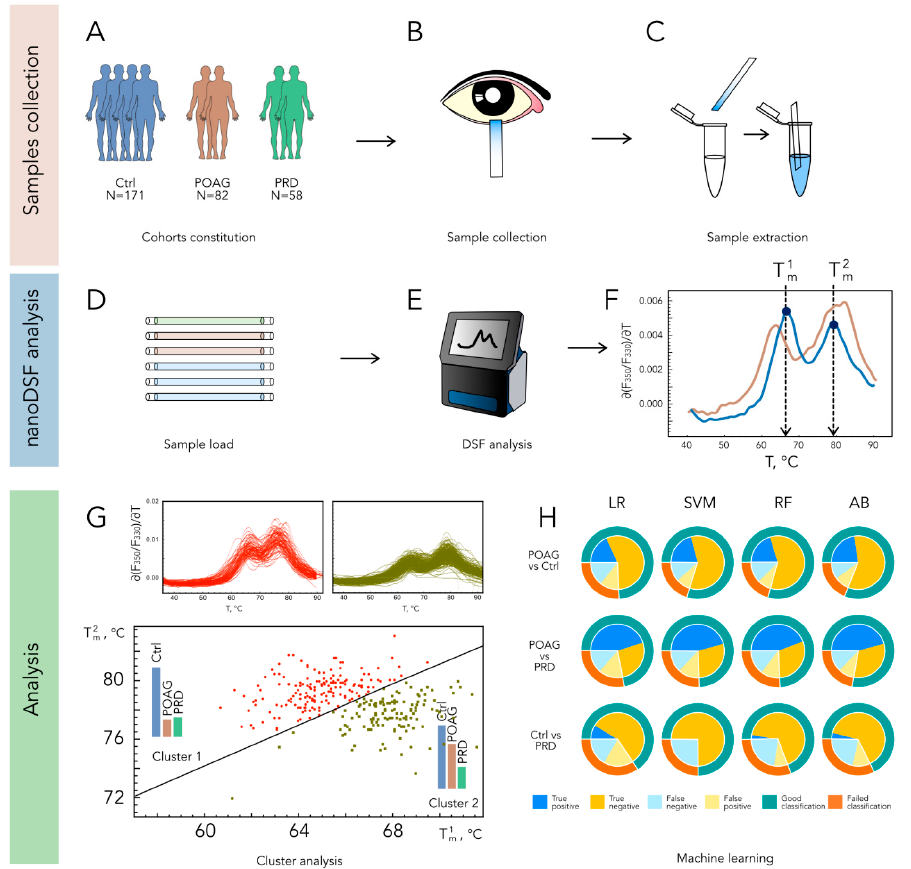
Figure 1. A workflow designed for the identification of POAG patients based on TFDP. Tear samples are collected using Schirmer tear strips in a cohort of individuals with refraction abnormalities (Ctrl), POAG, or PRD ( A – C ) and analyzed by nanoDSF yielding typical profiles with two peaks exhibiting characteristic shifts in POAG (( D – F ); normal and POAG-type TFDPs are indicated in blue and brown, respectively). The classification of patients is accomplished using k-means two-parameter clustering of the profiles according to peaks maxima (( G ); TFDPs belonging to clusters 1 and 2 are indicated in red and willow green, respectively), or AI analysis ( H ), where nanoDSF outputs are tested as input data for machine learning algorithms Logistic Regression (LR), Support Vector Machine (SVM), Random Forest (RF), and Adaptive Boosting